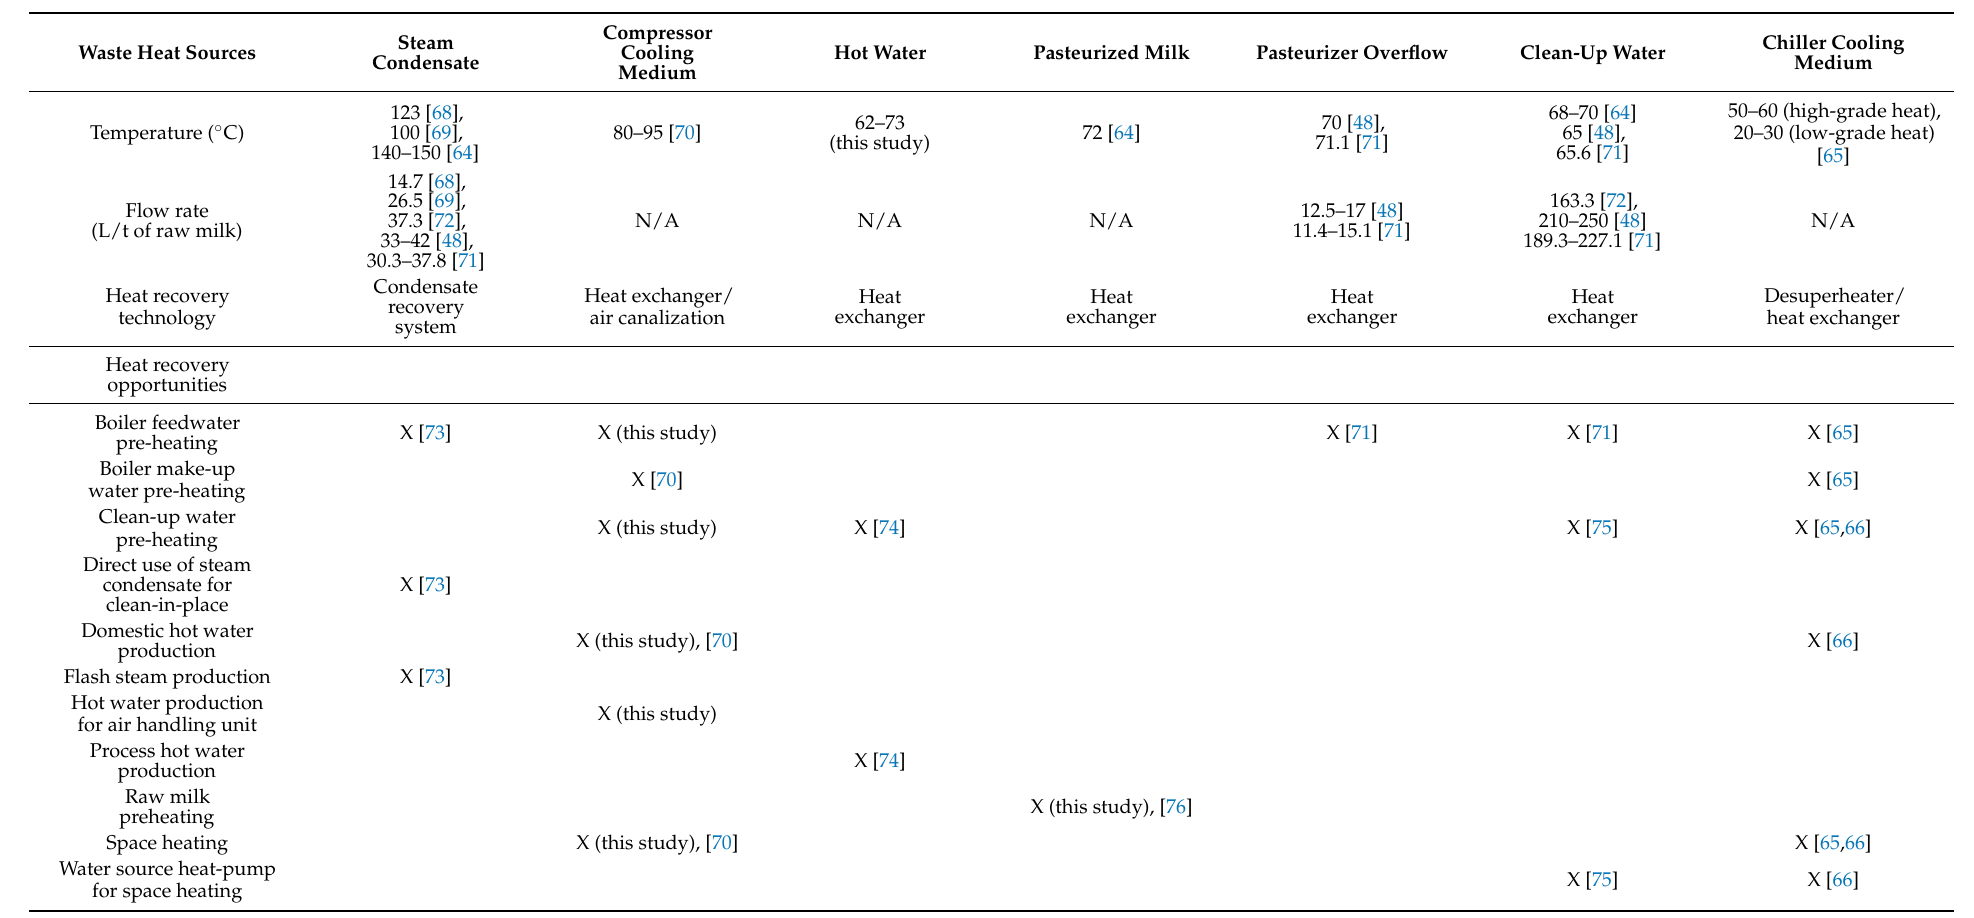
Table 6. Scheme providing the characterization of waste heat sources from raw milk pasteurization and the identification of possible heat